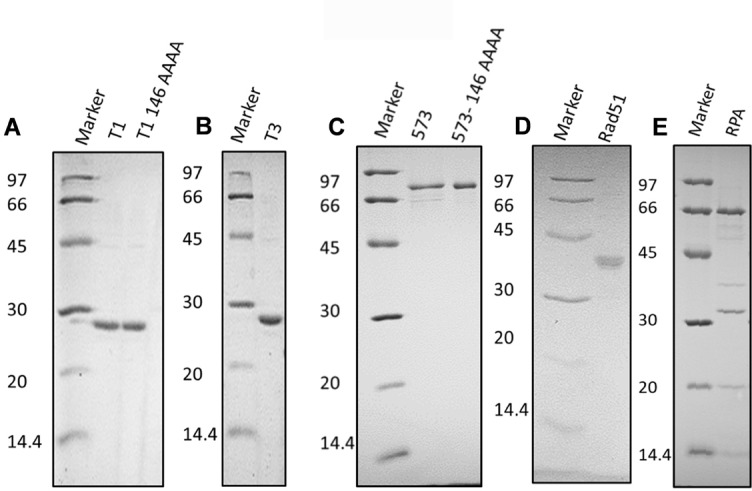
SDS PAGE analysis of purified proteins used in this study: (A) T1 and T1 146AAAA mutant, (B) T3, (C) PB2-573 and PB2-573 146AAAA, (D) RAD51, and (E) RPA.